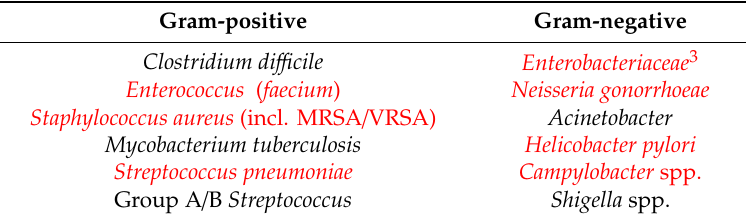
Table 1. Bacterial species highlighted in the World Health Organization (WHO) and Center for Disease Control and Prevention (CDC) priority pathogen reports 1 that produce O-acetylated peptidoglycan (PG) 2